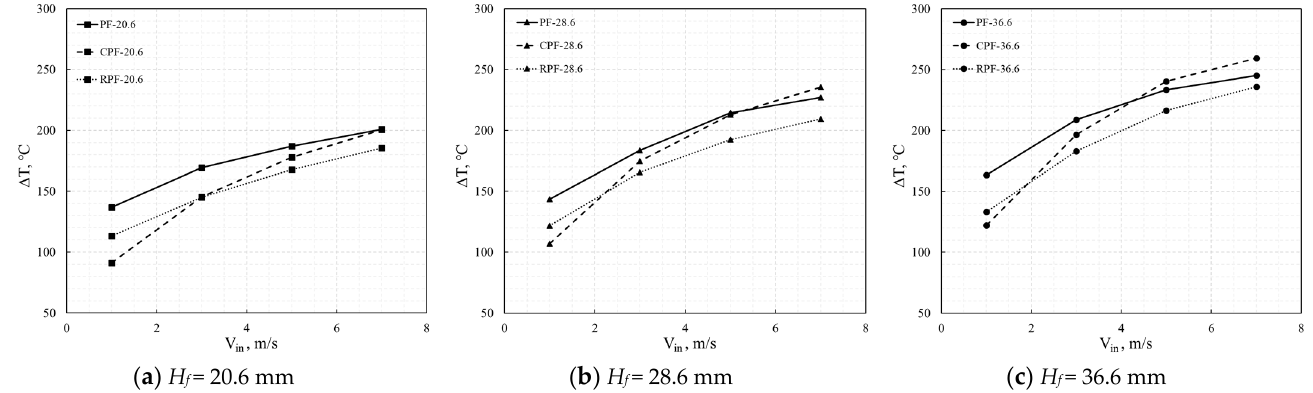
Figure 12. Temperature distributions of heat sinks with different fin structures and inlet velocities of flue gas ( H f = 28.5 mm, T in = 600 °C).